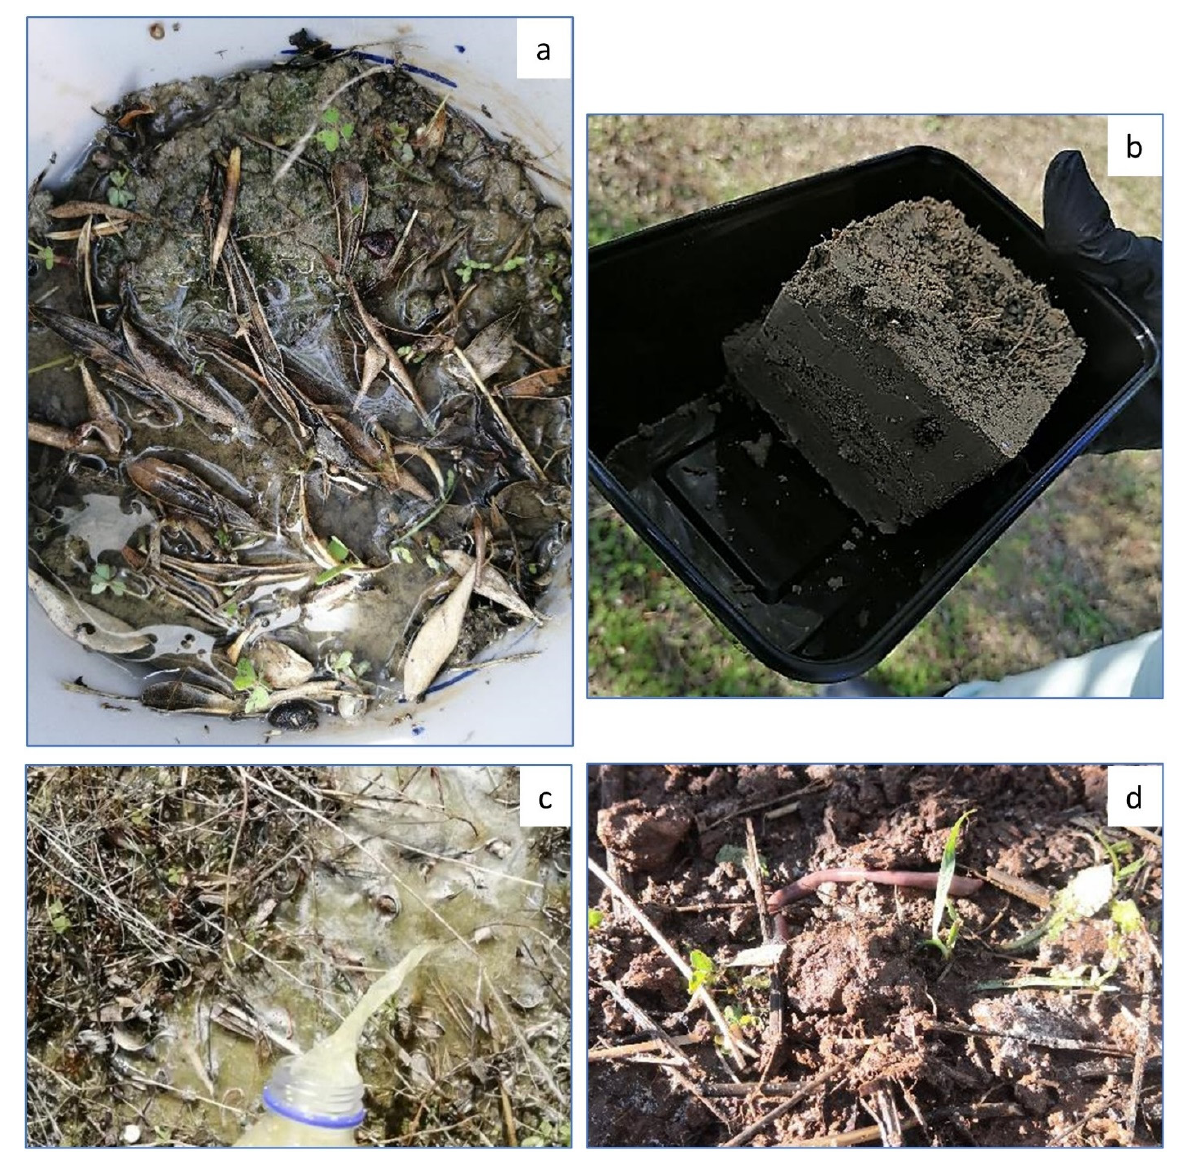
Figure 2. ( a ) Infiltration rate experiment, ( b ) soil sampling for bulk density measurement, ( c ) pouring mix of water and mustard for earthworm test in Astrikas, and ( d ) worms coming out to surface after the pouring of the mix in Alikambos.